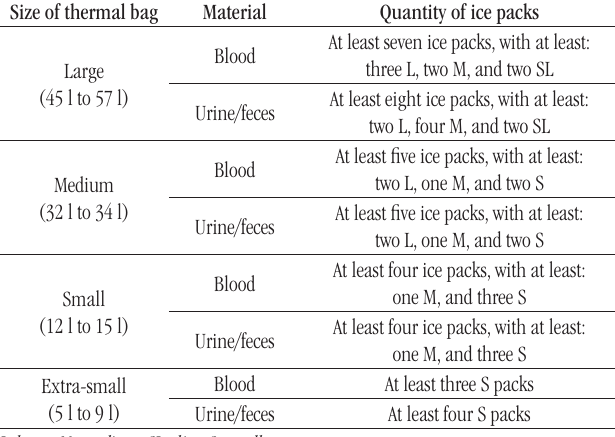
taBLE 1 − Specification of the quantity of ice by size of thermal bag Size of thermal bag Material